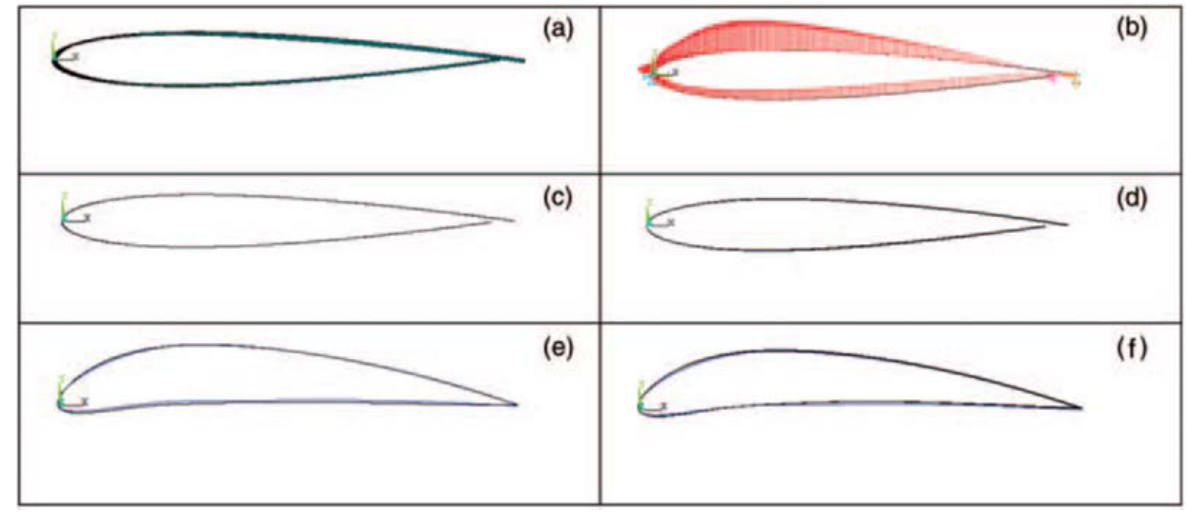
Figure 1. Optimization results (reproduced from [25]). ( a ) Thickness distribution; ( b ) aerodynamic loading; ( c ) unactuated unloaded; ( d ) unactuated loaded; ( e ) actuated unloaded; ( f ) actuated loaded.